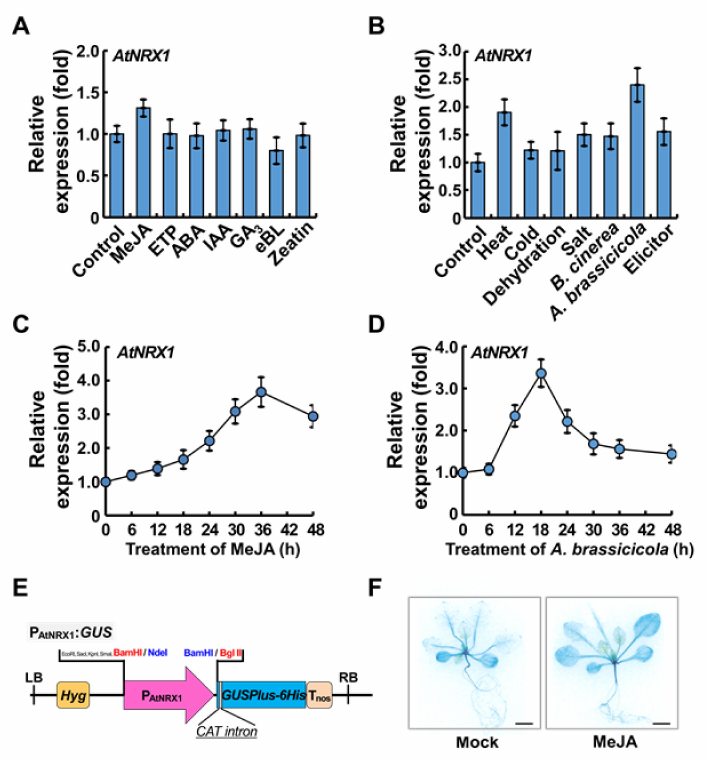
Figure 4. E ff ect of various stresses and plant hormones on AtNRX1 expression. ( A ) E ff ect of plant hormones on AtNRX1 expression. Seedlings were treated with 10 µ M methyl jasmonate (MeJA), 10 µ M ethephon (ETP), 10 µ M abscisic acid (ABA), 1 µ M indole-3-acetic acid (IAA), 1 µ M gibberellin A 3 (GA 3 ), 10 nM 24-epibrassinolide (eBL), and 20 µ M t-zeatin (zeatin) for 3 h. ( B ) AtNRX1 expression in response to various stresses. Seedlings were treated with high temperature (37 ◦ C for 2 h), low temperature (4 ◦ C for 6h), dehydration(air-driedfor12h), salt(300mMNaCl), fungalpathogens( Botrytiscinerea and